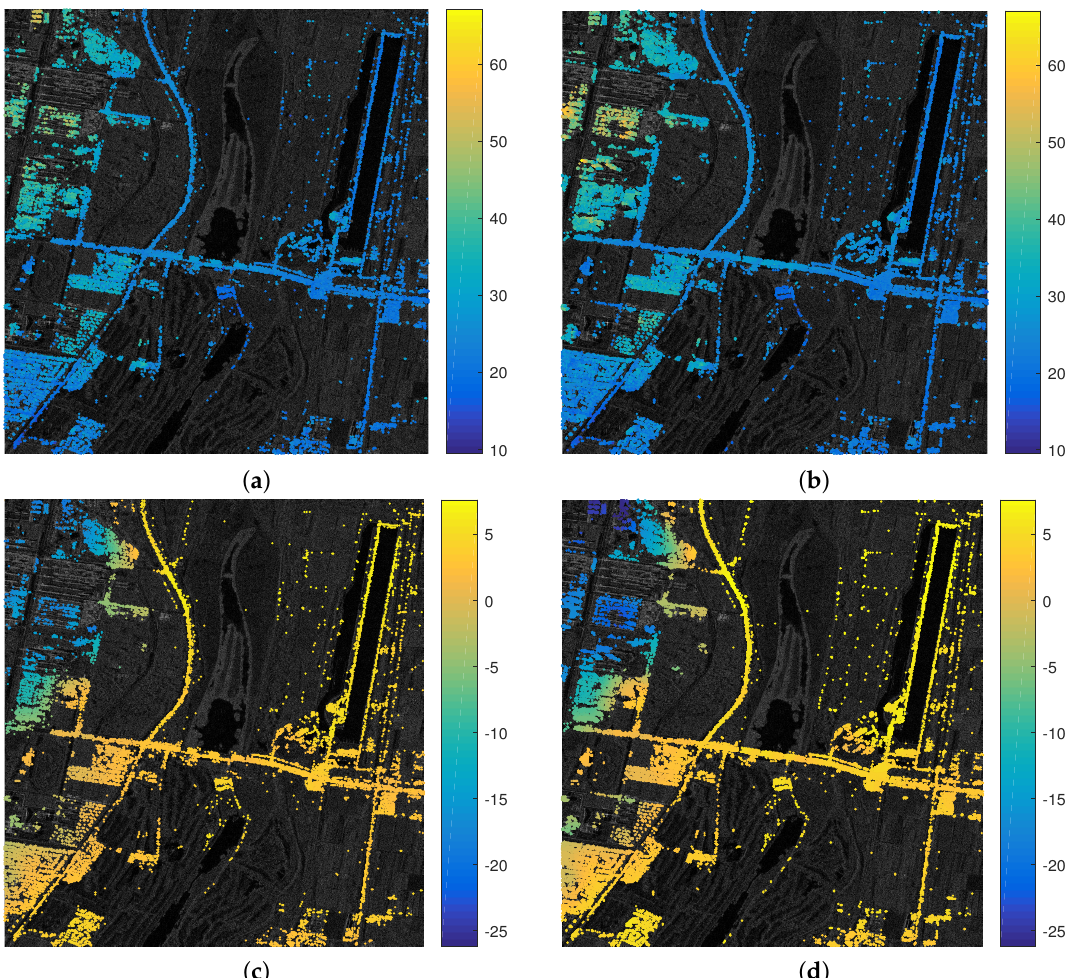
Figure 13. The reconstructed height and mean deformation rate maps of PS in Chaobai River area. The amplitude is plotted in the background. Height maps retrieved by ( a ) StaMPS and ( c ) IStaMPS ([m]); and mean deformation rate maps retrieved by ( b ) StaMPS and ( d ) IStaMPS